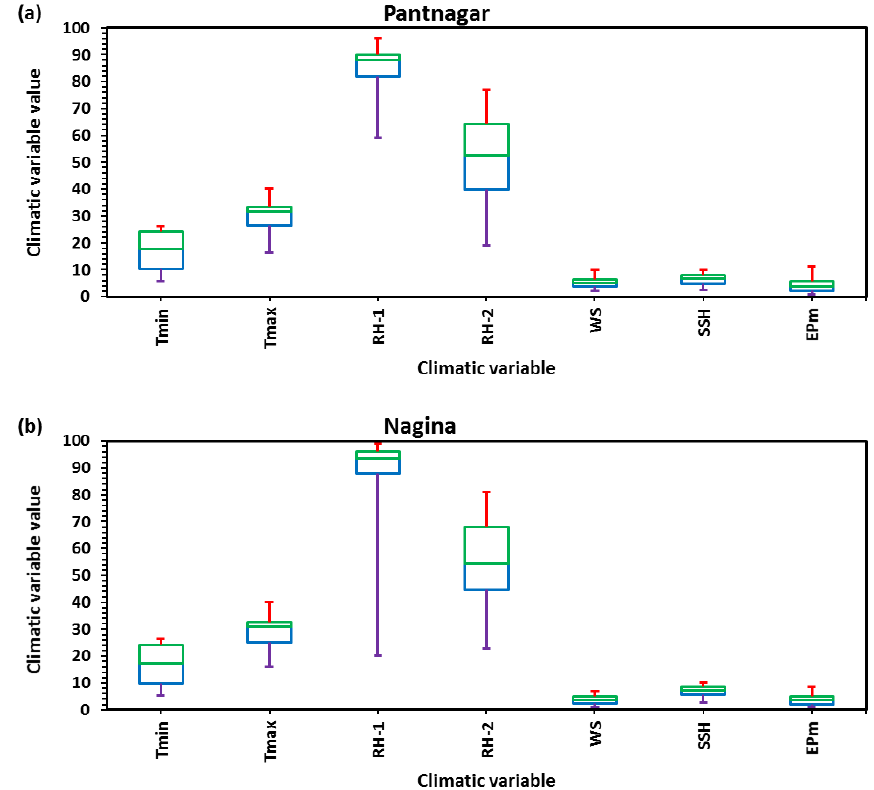
Figure 2. Box and whisker plot of climatic variables at ( a ) Pantnagar and ( b ) Nagina stations. Table 1. Statistical constraints of climatic variables at the study stations during 2009–2016.